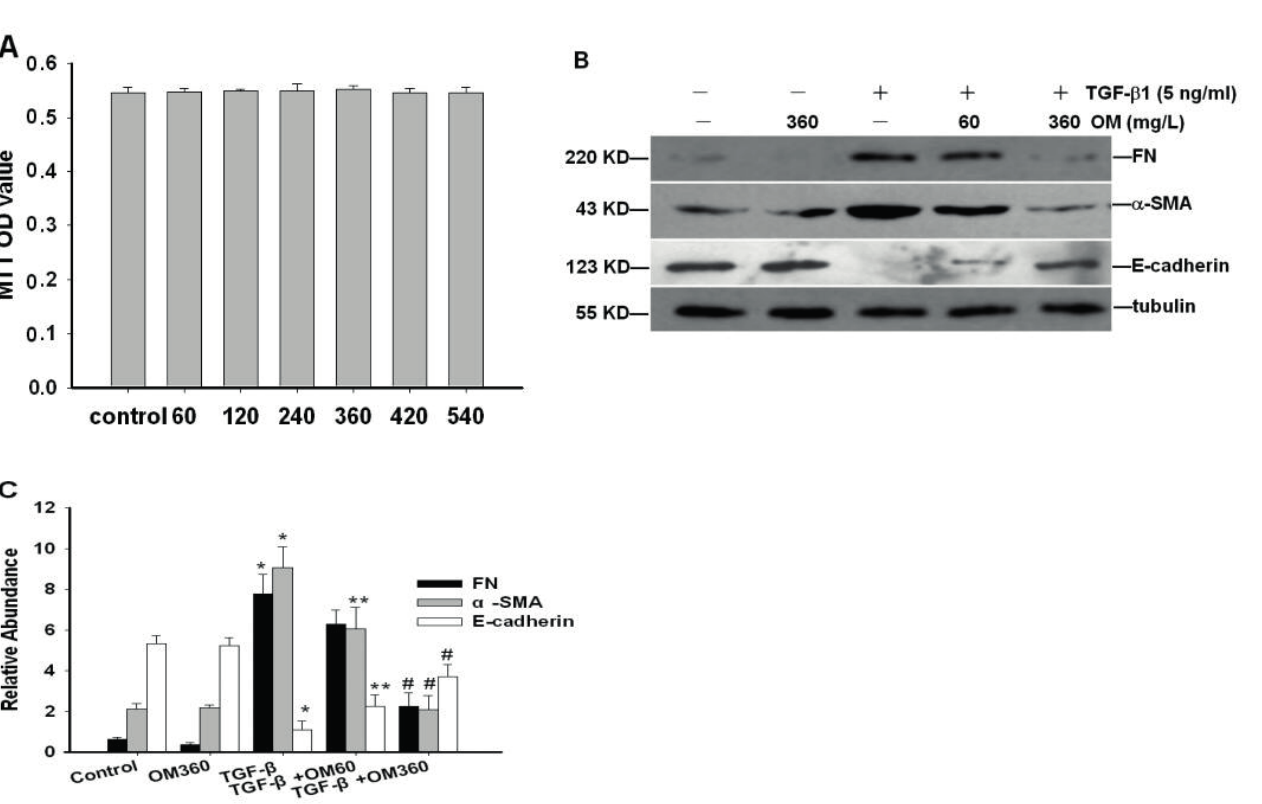
FIGURE 5 - The dose response effect of OM on proliferation of HK-2 cells At the conc entration of 60- 360 mg/L, OM increased cell viability in a dose-dependent manner, while above 360 mg/L this effect is not obvious although there was no statistically significant difference (A). OM blocks TGF- β 1-mediated EMT in vitro . HK-2 cells were treated without (control) or with 5 ng/ml TGF- β 1 in the presence or absence of various concentrations of OM as indicated for 48 H (B and C). Western blot showed that OM restored E-cadherin expression that was inhibited by TGF- β 1 in a dose-dependent manner, whereas it suppressed TGF- β 1-mediated induction of FN and α -SMA. Whole-cell lysates were immunoblotted with antibodies against FN, α -SMA, E-cadherin and tubulin, respectively. Densitometric analysis of three independent technical experiments (B and C). The data were normalized by the density of tubulin control. *: P<0.05 vs. control group, **: P<0.05 vs. TGF- β 1 group, #: P<0.05 vs. TGF- β 1 group,